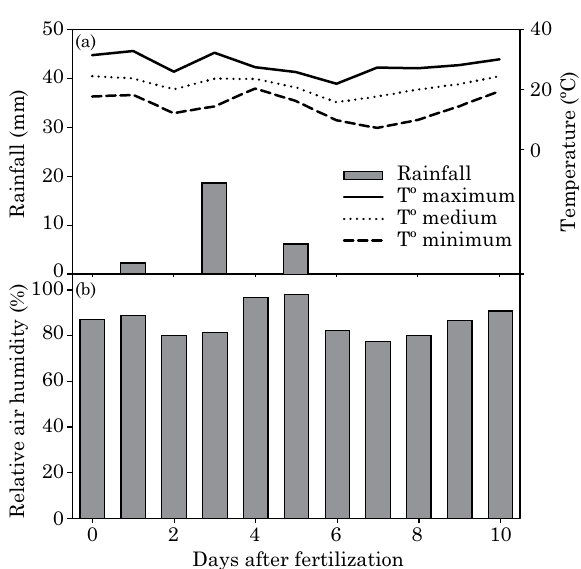
figure 1. rainfall; minimum, average and maximum daily air temperature (a); and air relative humidity (b) recorded during the experiment.